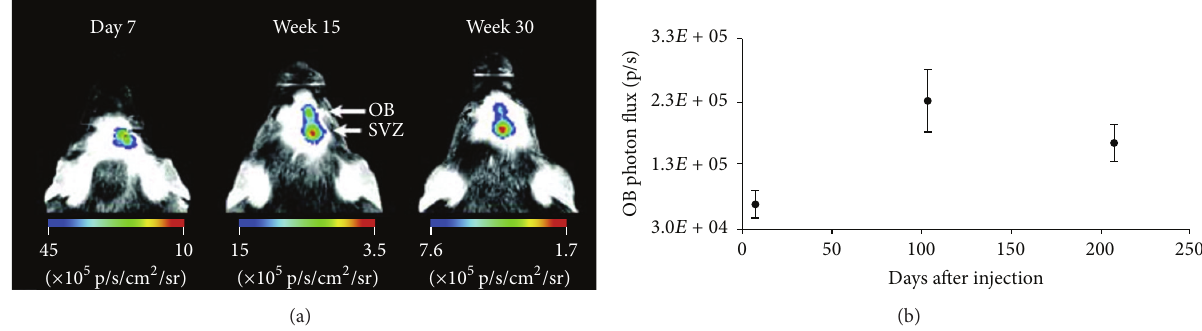
Figure 4: In vivo long-term follow-up of stem cell migration with bioluminescence imaging (BLI). (a) At day 7 after injection there was a detectable BLIsignal only at thesiteof injection (SVZ).At 15 and 30 weeks after injection an additional focus was detected at theOBprojection site, as well as the original focus at the SVZ. A representative mouse is shown. (b) The graph shows the quantification of the in vivo OB BLI signal from all the animals followed up for 30 weeks ( 𝑛 = 14 ). The OB photon flux at weeks 15 and 30 was significantly higher than that on day 7 ( 𝑝 = .002 and .045). OB, olfactory bulb; p, photons; s, second; sr, steradian; SVZ, subventricular zone